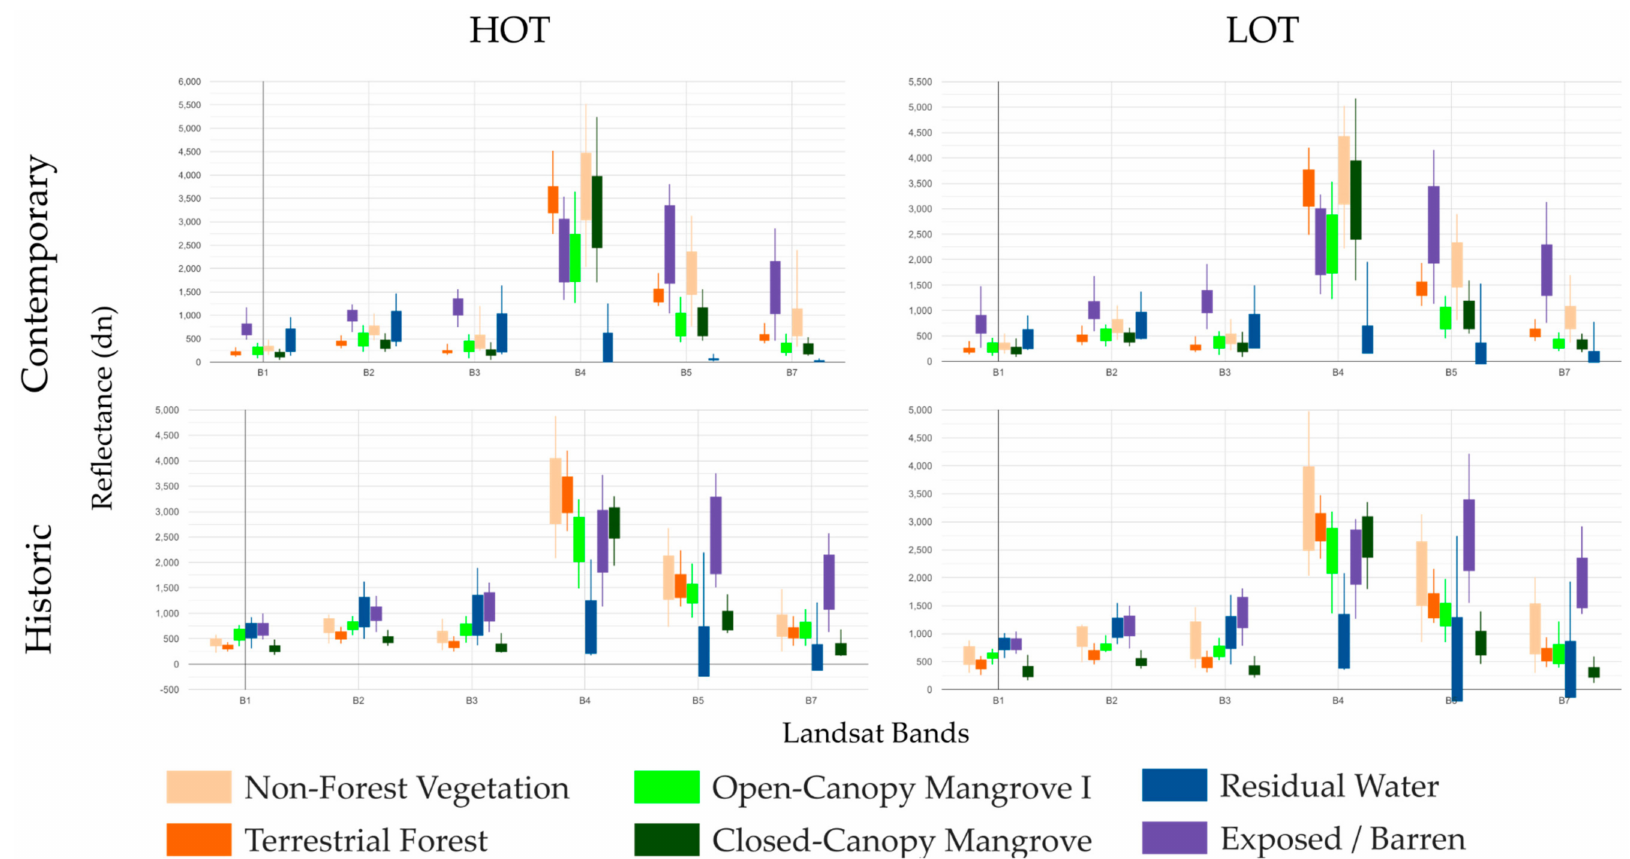
Figure 7. The spectral separability of all target classes as represented by CRAs across Landsat red (B1), green (B2), blue (B3), NIR (B4), SWIR1 (B5), and SWIR2 (B7) bands. The set of bar and whisker plots shows the min, max, and interquartile